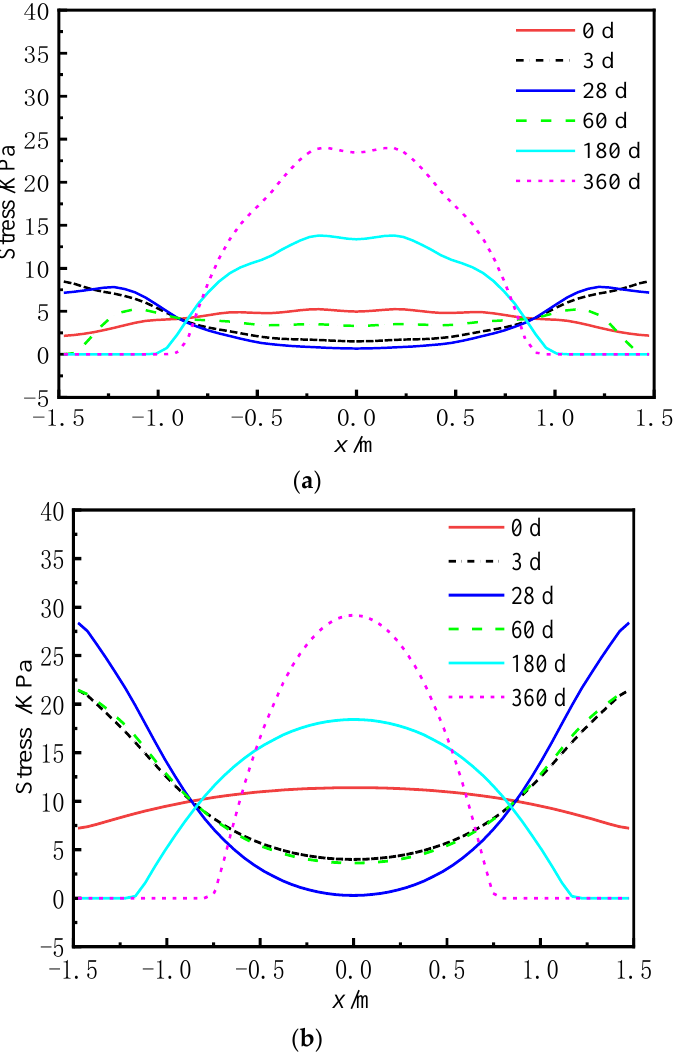
Figure 16. Normal stress of the sliding layer at the AOTSL of 60 d. ( a ) With the shear cogging. ( b ) Without the shear cogging.